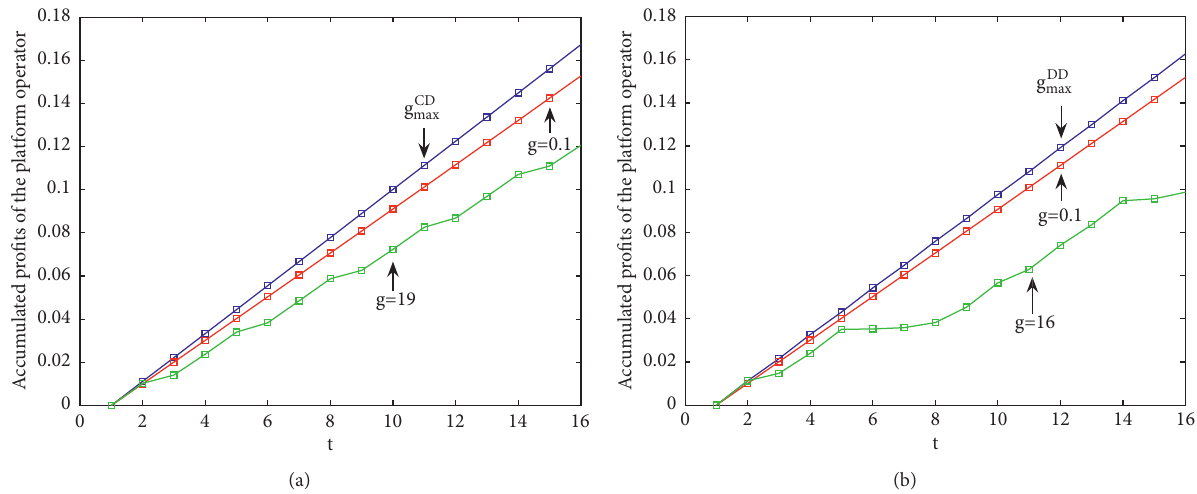
Figure 8: Accumulated profits of the platform operator with different g : (a) a � 1 . 5 ,c � 0 . 2 ,k � 0 . 2 in system CD and (b) a � 1 . 5 ,c � 0 . 2 ,k � 0 . 2 in system